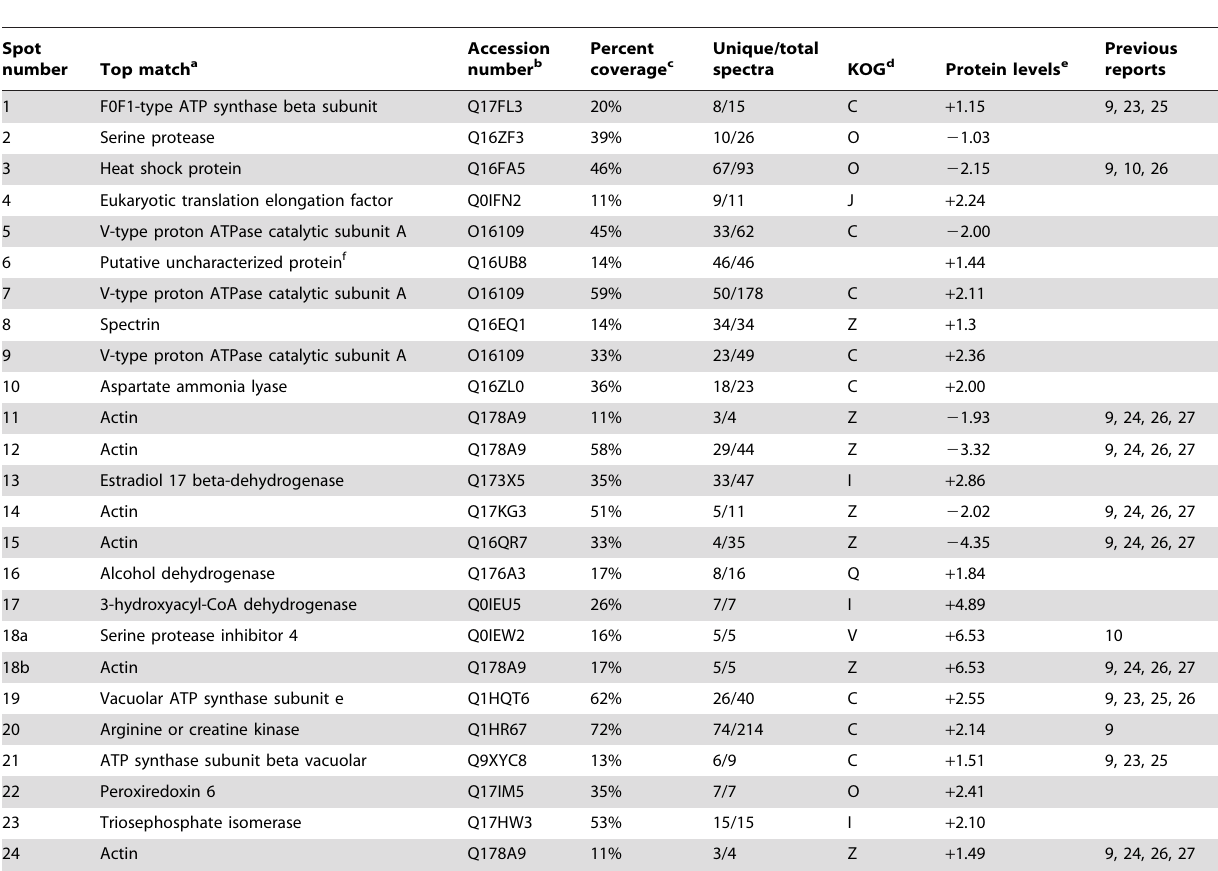
Table 1. Identification of proteins with significantly altered levels in A. aegypti larvae treated with an LC 10 (gray cells) or an LC 50 (white cells) dose of Cry11Aa toxin compared to buffer